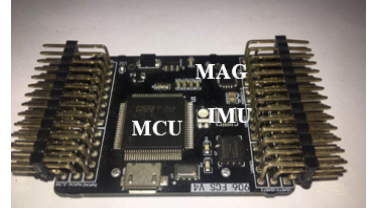
Figure 1. The self-designed miniature low-cost attitude sensor